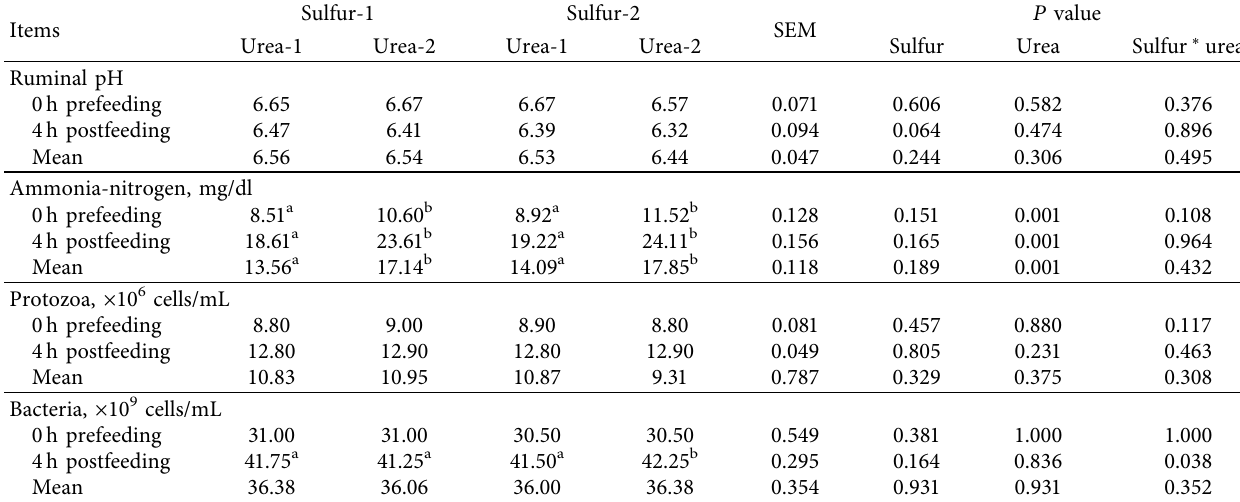
Table 3: Effect of sulfur and urea levels on rumen ecology in dairy